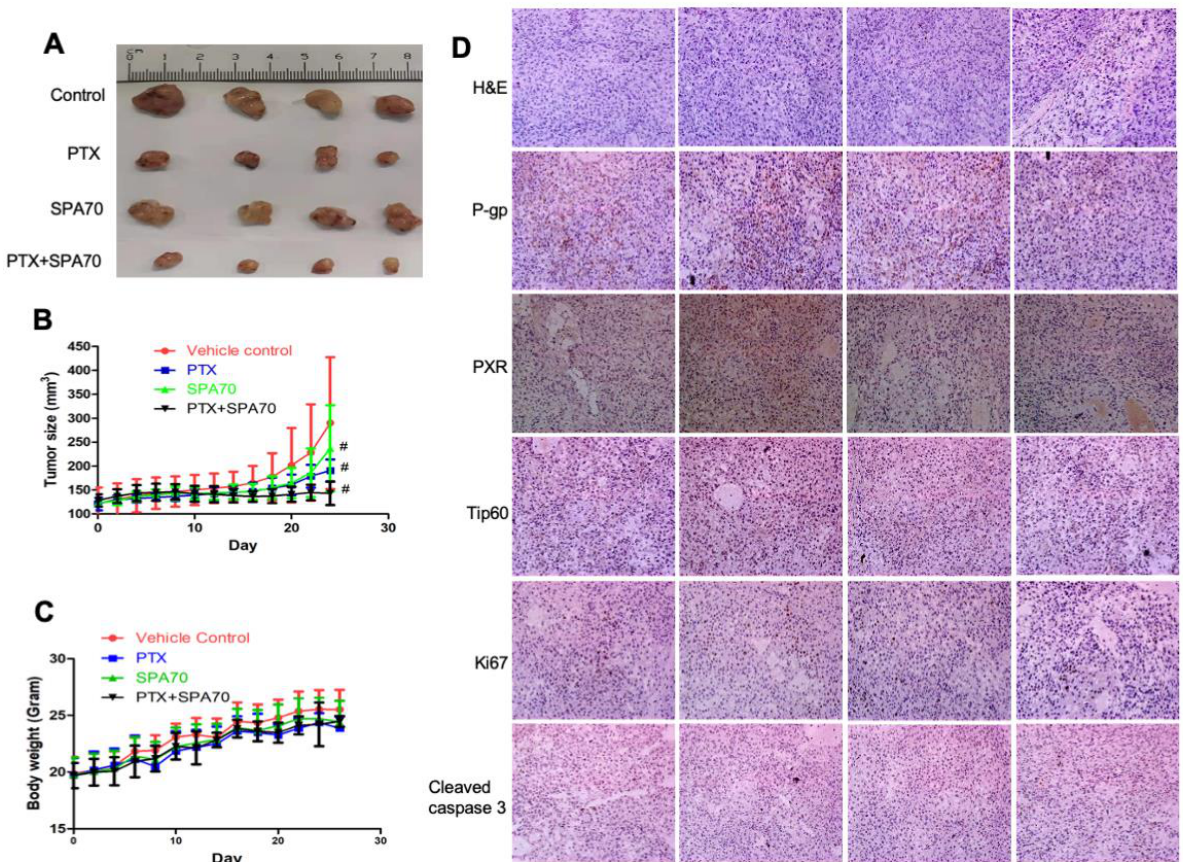
Figure 6. Additive effect of PTX and SPA70 in PTX-resistant A549/TR xenograft tumor growth. BALB/c-Nude mice were treated with 5 mg/kg paclitaxel with or without SPA70 intraperitoneal injection three times per week. ( A ) The photograph of xenograft tumors in all groups. ( B ) The volume of the xenograft tumors from the combination group was remarkably smaller than the vehicle control and single compound groups. #, p < 0.05, compared with vehicle administration groups. ( C ) Mice body weight curves over drug administration time period. ( D ) H&E and IHC staining of tumor tissues revealed remarkably reduced expressions of P-gp, along with diminished PXR and Tip60 expression, decreased proliferation (Ki67), and increased cell apoptosis (cleaved caspase 3) in the combination treatment group. The photographs were taken by microscopy (200 × ). Table 3. TGI value of combination of PTX (5 mg/kg) and SPA70 (30 mg/kg) in the PTX-resistant A549/TR xenograft tumor model.